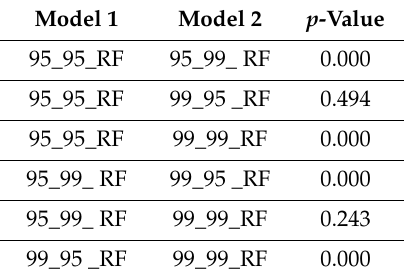
Table 17. p -value for t -test comparison the for RF models (tested against raw data).